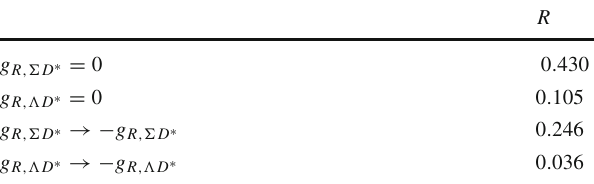
Table5 Valuesof R